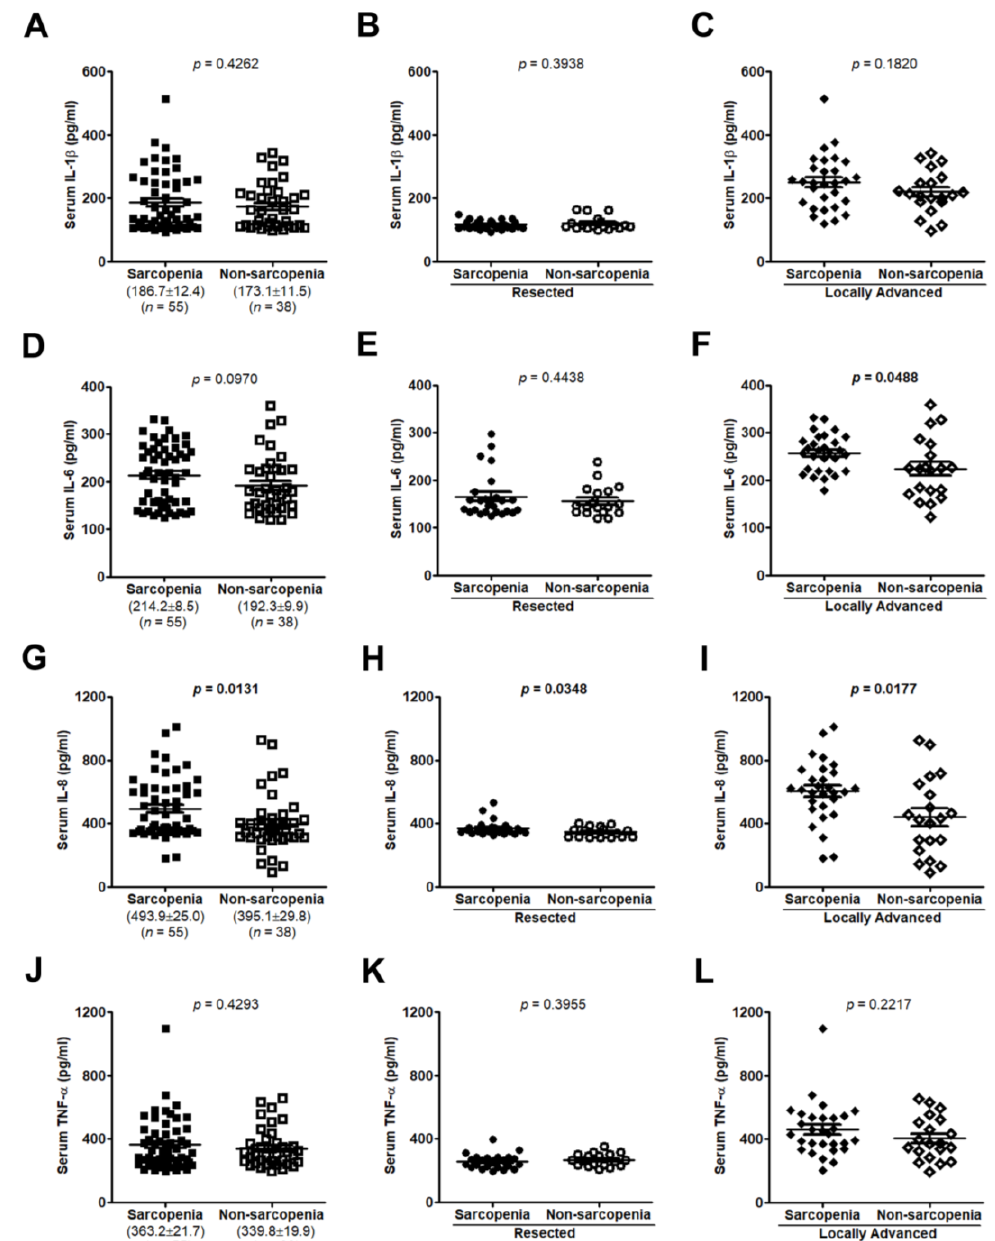
Figure 6. Serum IL-1β, IL-6, IL-8, and TNF-α levels in PC patients according to sarcopenia status. IL-1β, IL-6, IL-8, and TNF-α concentrations in patients with or without sarcopenia from all samples ( A , D , G , and J ), the resected group ( B , E , H , and K ), or the locally advanced group ( C , F , I , and L ) were measured by ELISA. Values represent mean ± standard error of the mean; two-tailed Student’s t -test. Sarcopenia, patients with sarcopenia; Non-sarcopenia, patients without sarcopenia.